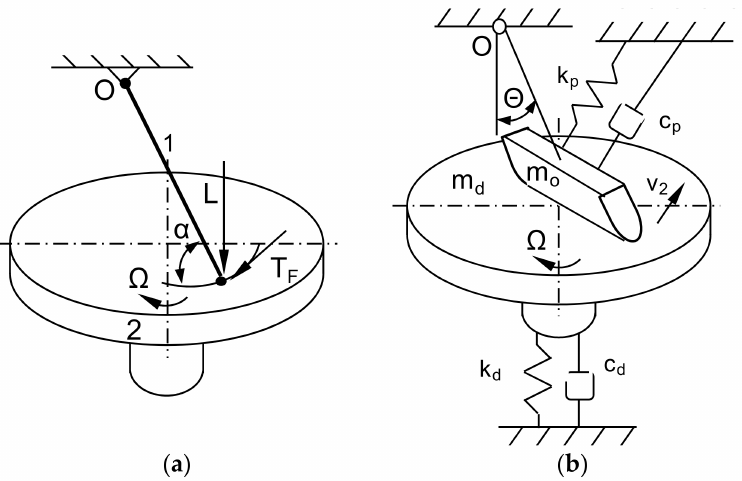
Figure 2. Models of brake systems: ( a ) Model of the sprag-slip phenomenon according to Spurr, 1—stiff rod rotating at point O, 2—stiff rotating disc; ( b ) Model of the friction disc-slider system on the Jarvis and Earles angle cantilever, α —slope angle of cantilever in the horizontal plane, Z— bracket width in m, R—bracket rotation radius in m, Ω —plate rotation speed in rpm, θ —cantilever slope angle in the vertical plane, v 2 —slider linear speed in m/s, m o —weight of the cantilever in kg, m d —weight of the panel in kg, c p —cantilever damping, k p —cantilever stiffness, c d —disc damping, k d —disc